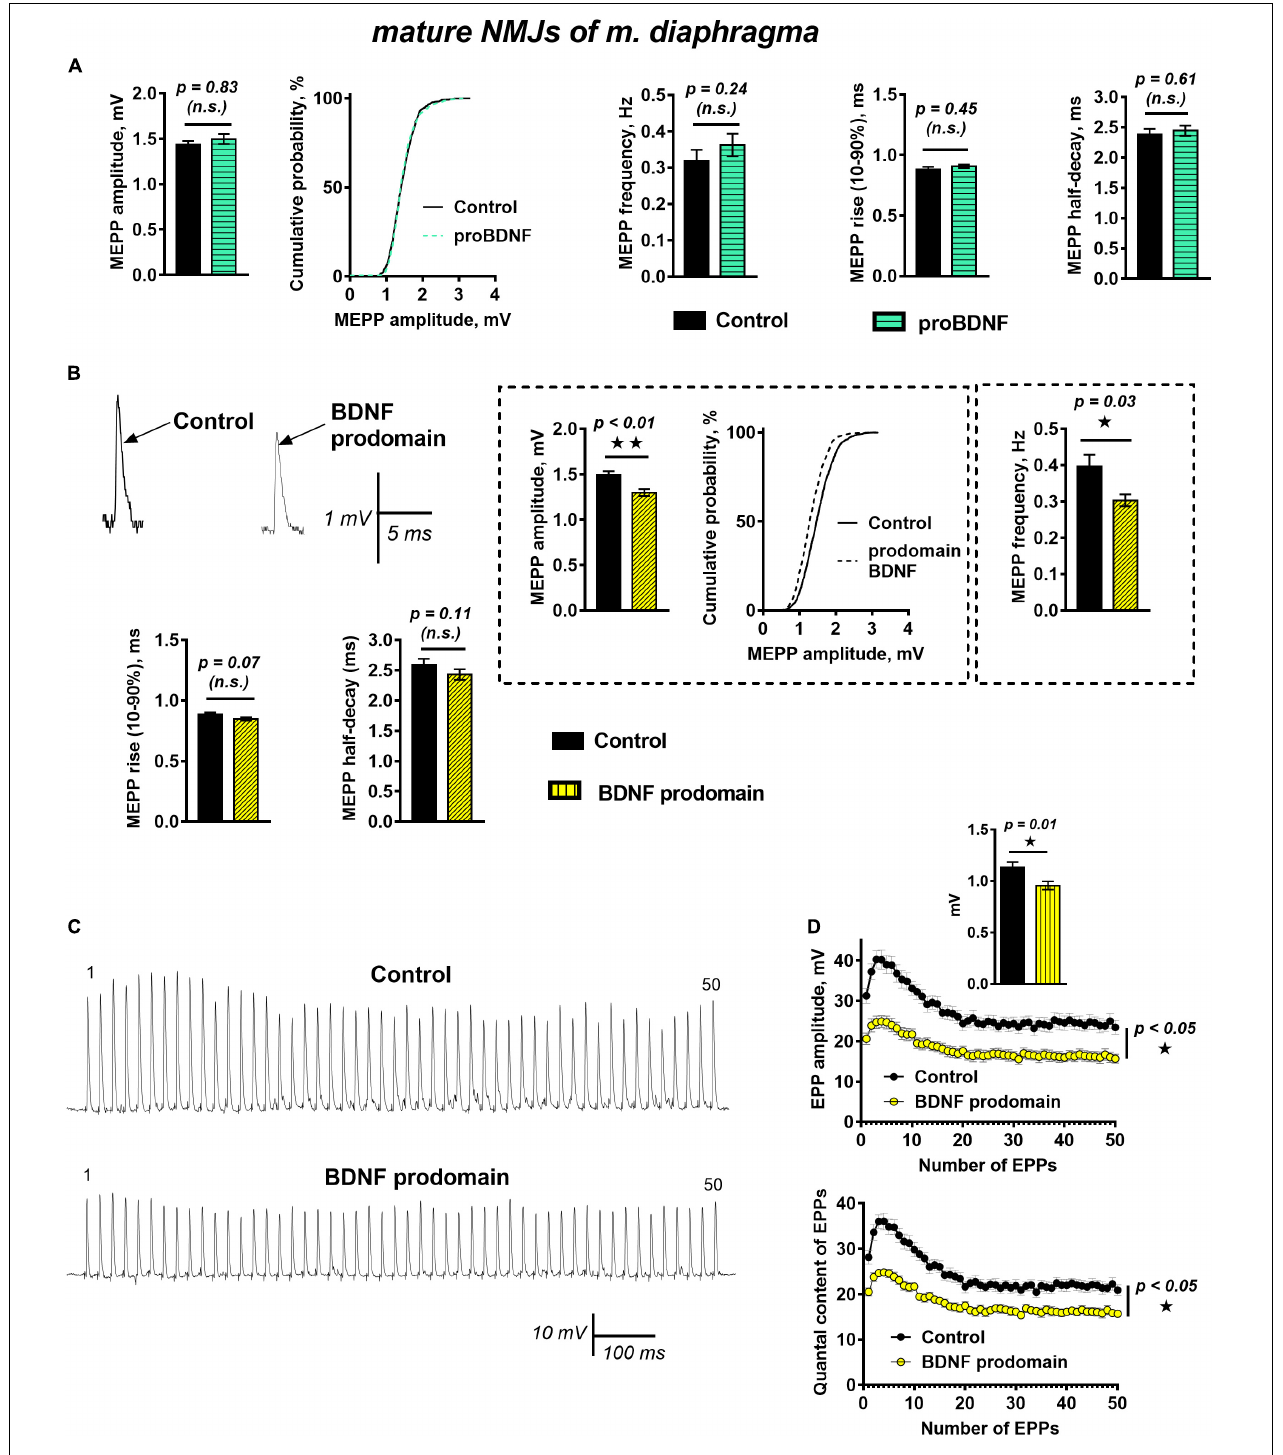
FIGURE 4 | BDNF prodomain (1 nM) but not proBDNF (1 nM), induces strong inhibition of spontaneous end evoked ACh release at mature NMJs. (A) Mean MEPP amplitude, cumulative probability plots, frequency, and time-course parameters (left to right) in control ( n = 19) and upon application of proBDNF ( n = 26). (B) Representative recordings of MEPPs (top left) and mean MEPP amplitude, cumulative probability plots, frequency, (top right) and their time-course parameters (bottom) in control ( n = 23) and upon application of BDNF prodomain ( n = 33). (C) Representative recordings of EPPs during a short (1 s) high-frequency (50 Hz) train in control (above) and upon application of BDNF prodomain (below). (D) Changes in the EPP amplitude (above) and in the quantal content of EPPs (below) in control ( n = 22) and in the presence of proBDNF ( n = 21). Inset shows MEPP